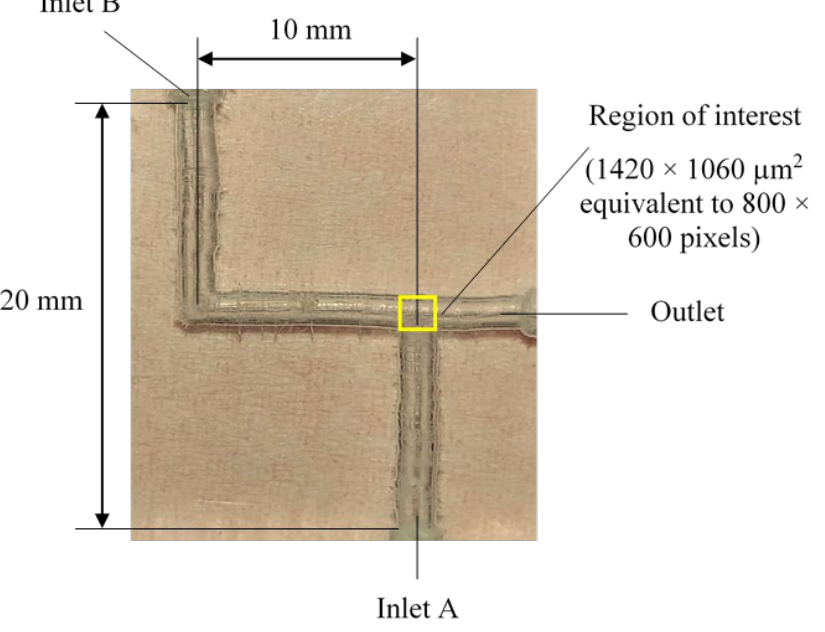
Figure 1. Fabricated offset T-junction microchannel with an inlet and outlet radius of 750 µm.